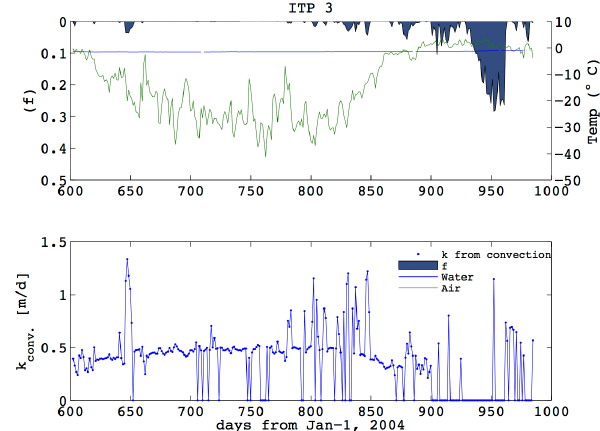
1 Figure 7. Top panel: Surface air and water temperature and fraction of open water along the ITP 2 Fig. 7. (top) Surface air and water temperature and fraction of open 3 drift track. Bottom panel: Gas transfer velocity ( k conv. ) resulting from heat flux-driven 3 water along the ITP 3 drift track. (bottom) Gas transfer velocity convection in the IOBL. 4 ( k conv ) resulting from heat flux-driven convection in the 5